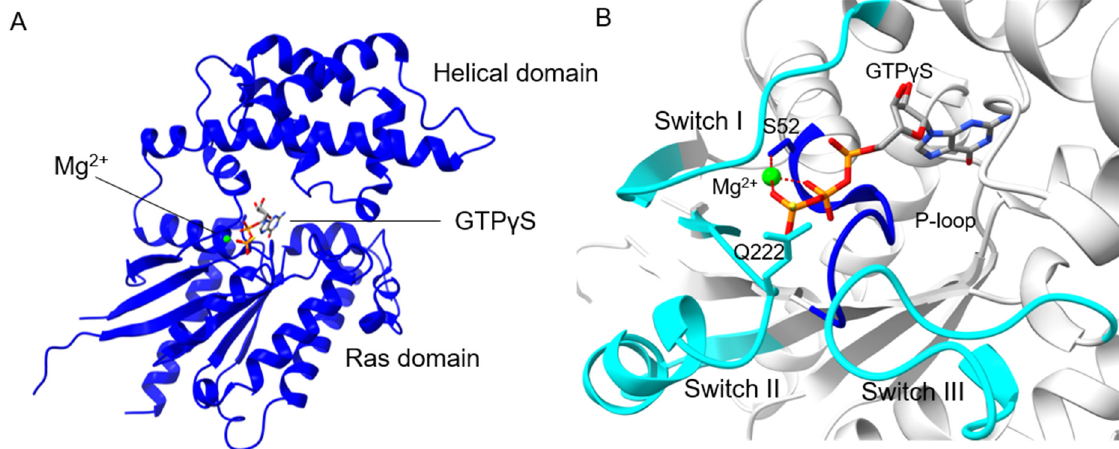
Figure 2. The structure of the Arabidopsis canonical G α subunit (AtGPA1) in its GTP γ S-bound form. ( A ) Overall tertiary structure of AtGPA1 (PDB: 2XTZ), showing the Ras domain and the helical domain. ( B ) Close-up view on the nucleotide- binding pocket with three switch regions highlighted in cyan and the G1 box (also known as the P-loop) highlighted in blue. Side chains of Ser 52 (P-loop) and Gln 222 (Switch II) are shown. The Mg 2+ ion coordinates the side chain of Ser 52 and the β - and γ -phosphate moieties of GTP, indicated in red lines (dash). The side chain of Gln 222 hydrogen bonds with two water molecules providing hydrolysis of GTP.